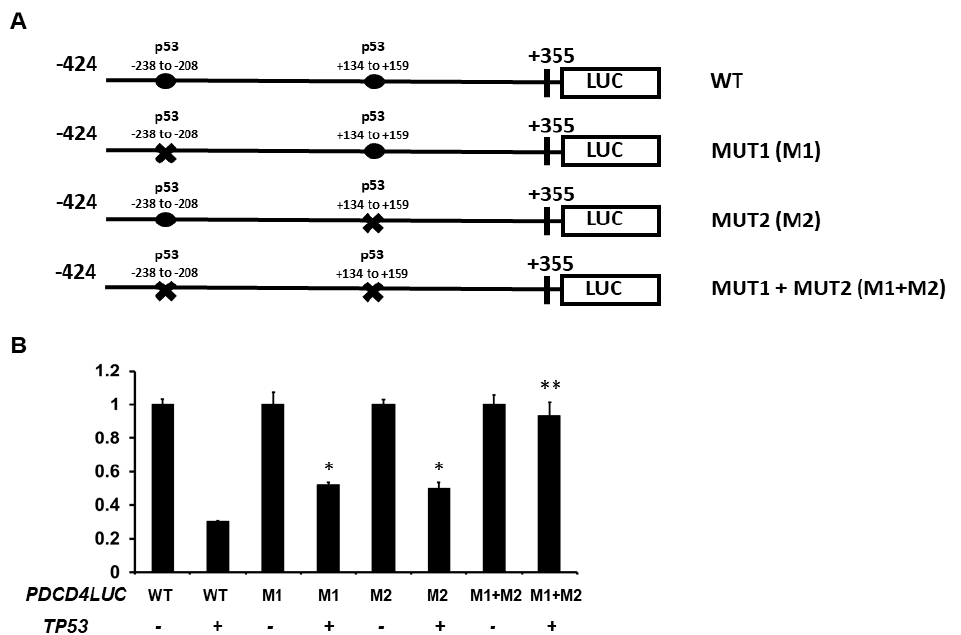
Figure 4. Regions of the PDCD4 promoter important for transcriptional down-regulation by p53. ( A ) Experimental design: H1299 cells were co-transfected with p53 expression plasmids with either − 424 wild-type (WT), − 238 to − 208 RE mutated (M1), +134 to +159 RE mutated (M2), or both M1 + M2 PDCD4 promoter constructs. ( B ) Reporter Assays: After forty-eight hours of transfection, luciferase activities were analyzed by the Dual-Luciferase Reporter System and normalized to the control Renilla activity. Relative LUC activity was calculated and plotted. * indicates a p -value < 0.05 compared with PDCD4 LUC WT + TP53 . ** indicates a p -value < 0.01 compared with PDCD4 LUC WT + TP53 .